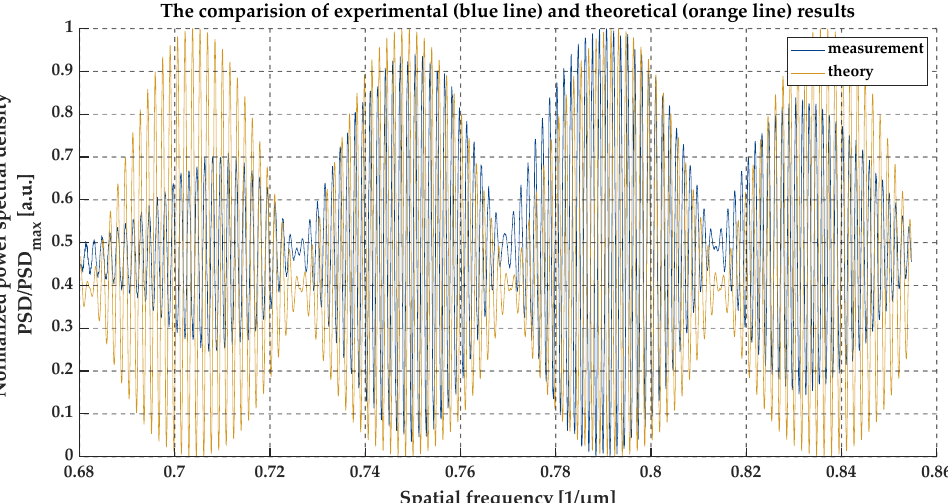
Figure 12. A comparison of experimental (blue line) with theoretical (orange line) results.